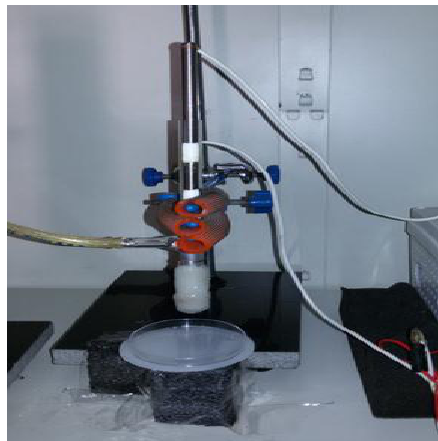
Fig.1: The non-thermal plasma needle system.